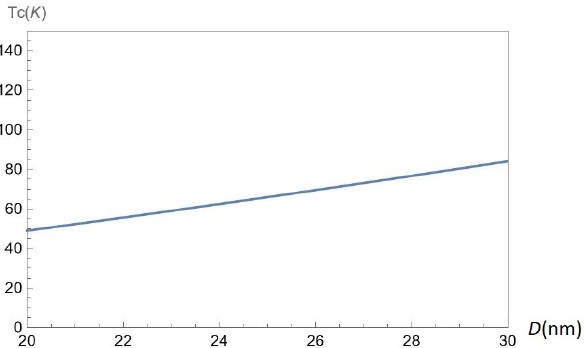
Figure 13. The mean-field phase transition critical temperature T c ( n A , n B , α , ∆ , D ) versus the inter- layer separation D for chosen parameter α = 0.6 and gap ∆ = 0.5 ¯ hv F / a , at fixed concentrations n A = 50 × 10 11 cm − 2 and n B = 50 × 10 11 cm − 2 of A and B excitons, respectively.